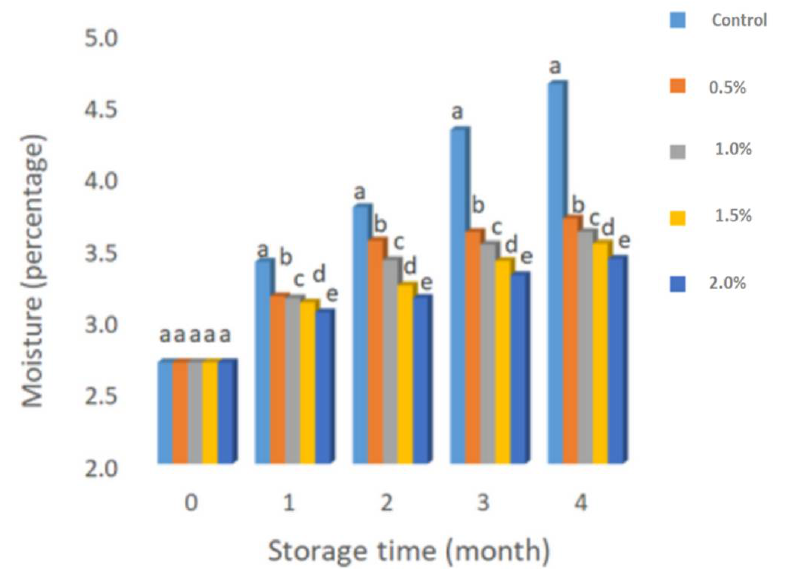
Figure 1. Changes in the moisture content (%) of uncoated (control) and coated almond kernels during 4 months of storage. ( p < 0.05) between the samples during each month; share a lowercase letter are not statistically different, while different letters denote for statistical differences at least 95%